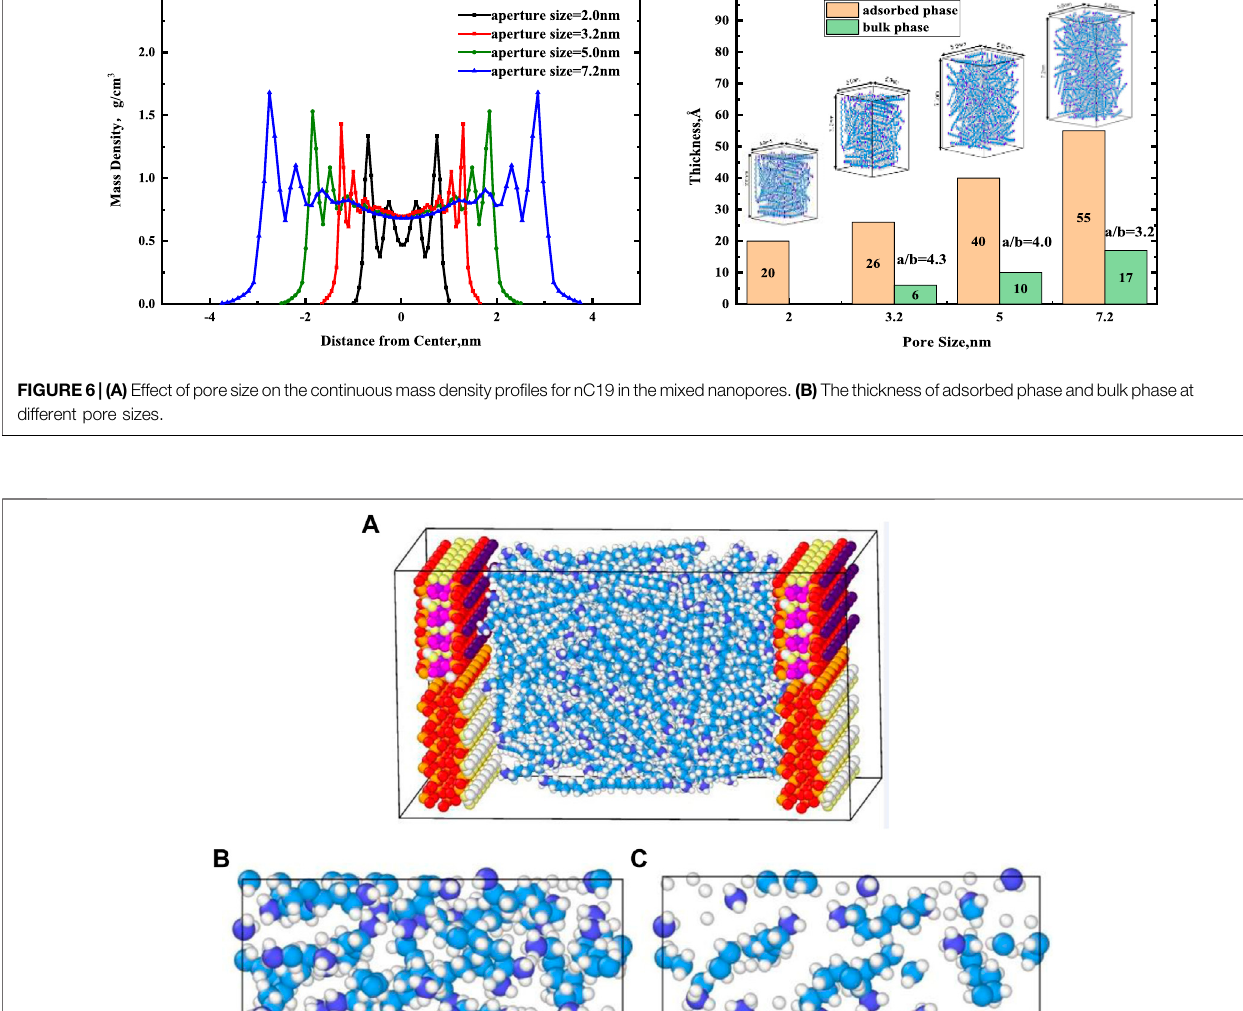
adsorbed layer. The adsorbed layers of different pore sizes were then compared. The thicknesses of the fi rst and second adsorbed layers are about 4.4 and 5.6 Å in a 2.0 nm pore. The thicknesses of the fi rst adsorbed and other adsorbed layers are about 2 and 3.5 Å in a 3.2 nm pore. The values in a 5 nm pore are 3.5 and 5.5 Å. In 7.2 nm pore, the thicknesses are 5.5 and 7.5 Å. The thickness of the fi rst adsorbed layer is smaller than the other three adsorbed layers. The interactions between the mixed solid surface and nC19 molecules gradually decreased, and the intermolecular interactions among nC19 molecules were enhanced. Figure 6B depicts the total thickness of the adsorbed phase and bulk phase.